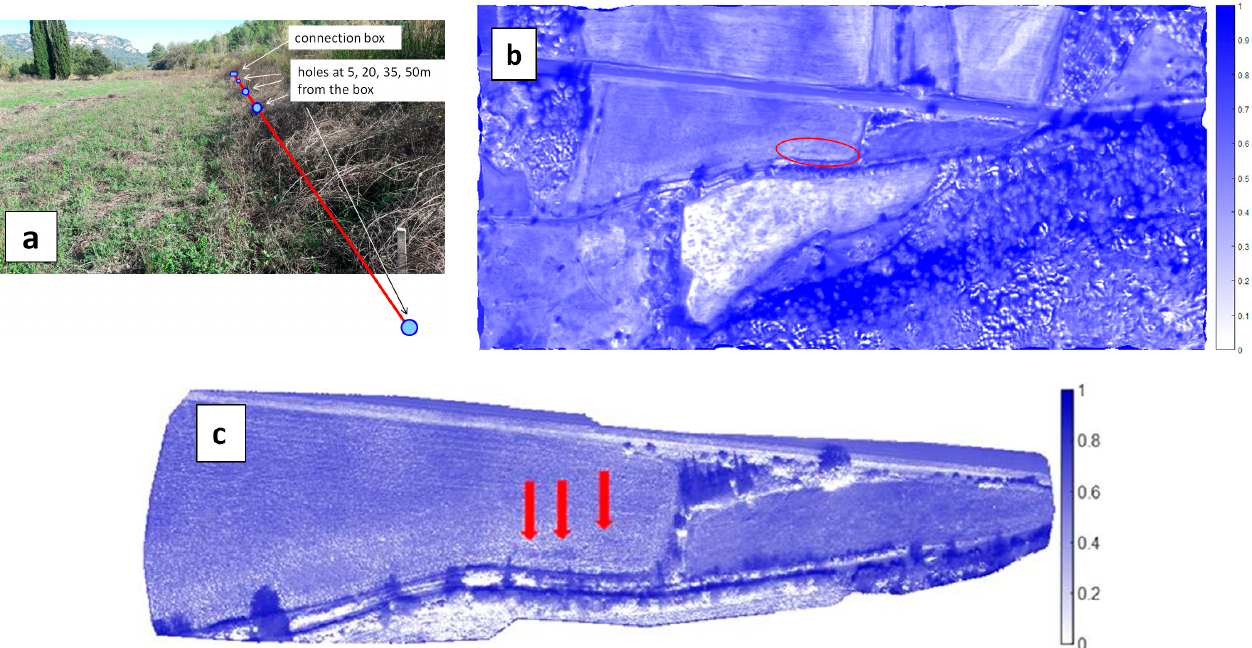
Figure 10. ( a ) Picture of the Vauvenargues test area with artificial leaks. Picture taken towards the east from leak n°4 (stick in the bottom right of the image) with the connection box in the background, in front of the trees. The leaking pipe (red line) is running from background to foreground at the limit between the high ‐ grass area in the south and the low ‐ grass area in the north. ( b ) WI map in the Vauvenargues test area obtained on 22 October 2018 with the MAV. The leaking pipe is along the long axis of the red ellipse; ( c ) same with the UAV. Spots with faint contrast close to the leaking pipe are shown with red arrows.